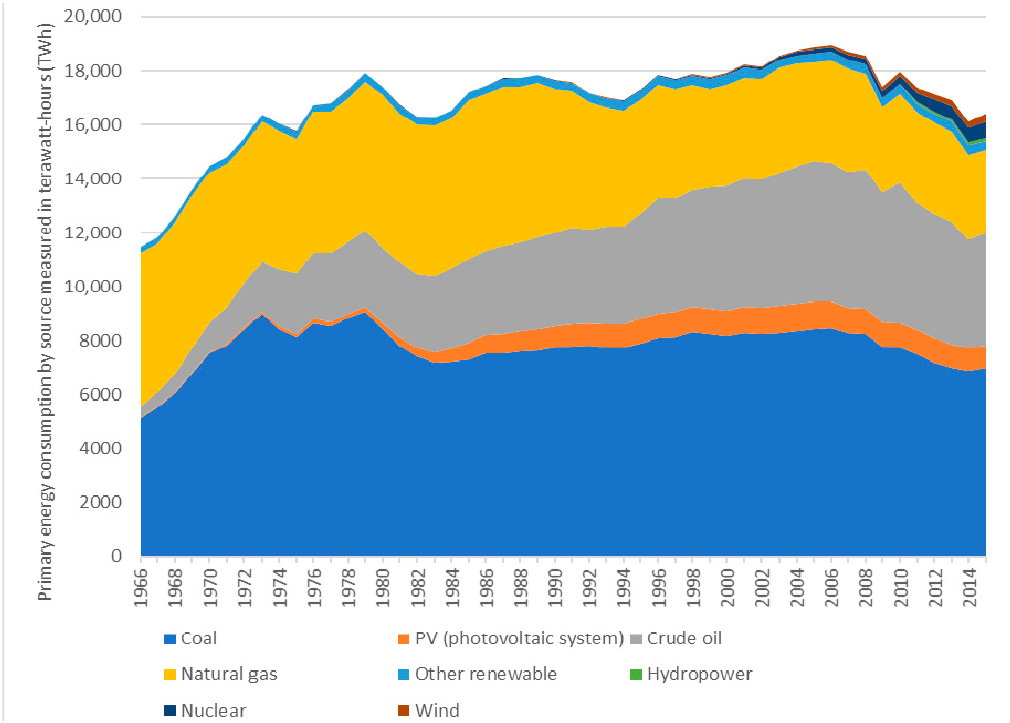
Figure 4. Primary energy consumption by source, European Union [19].